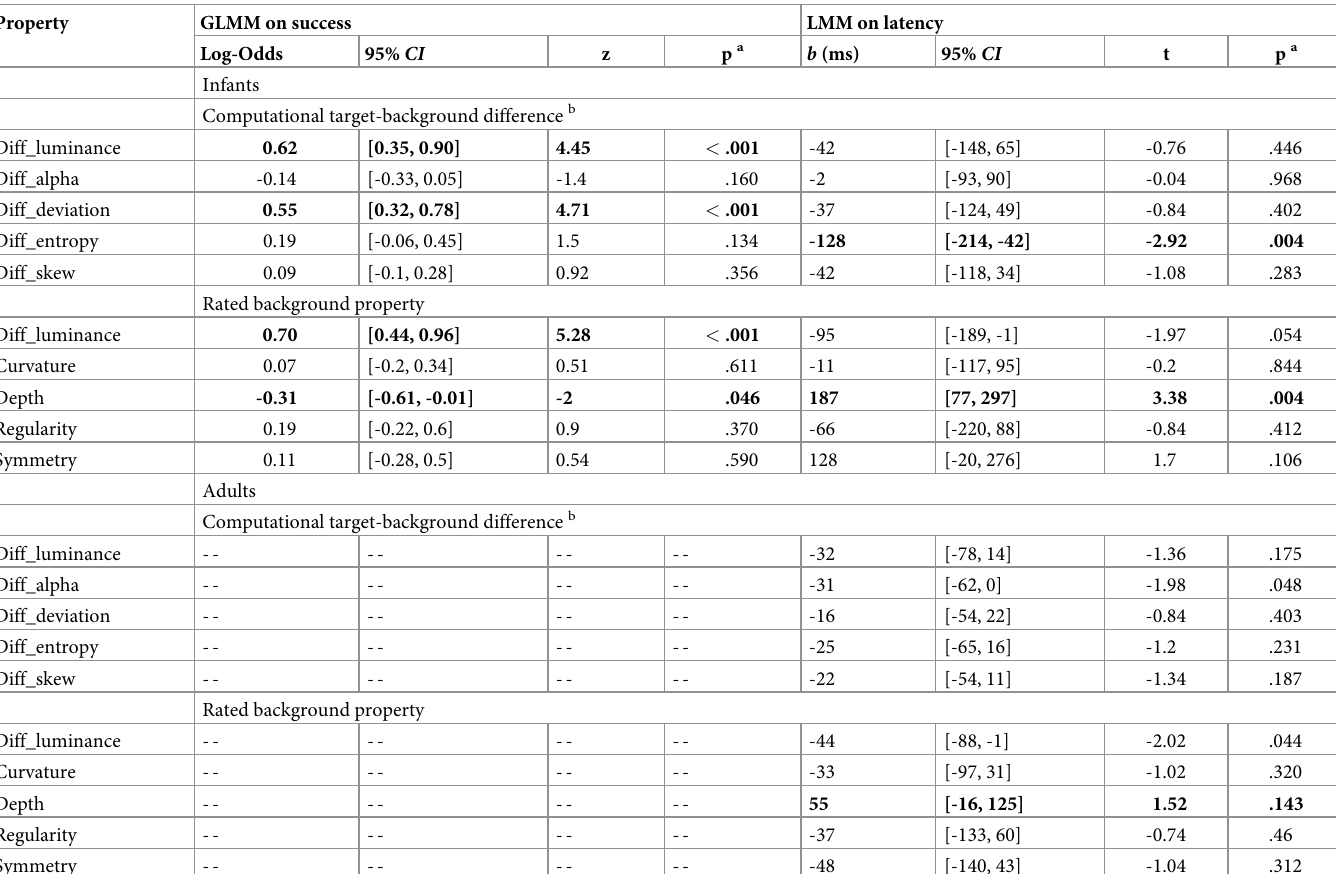
Table 4. Results of structure-related properties that predicted detection